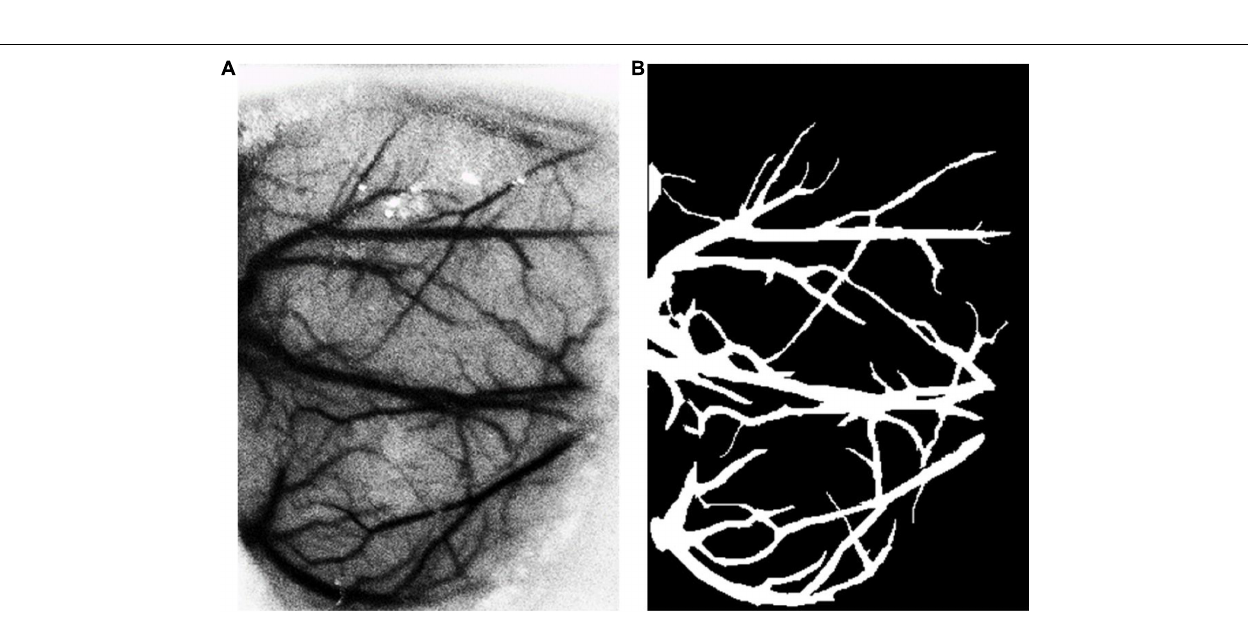
FIGURE 1 | (A) A sample of fundus image and (B) its ground truth from the digital retinal images for vessel extraction (DRIVE) dataset.